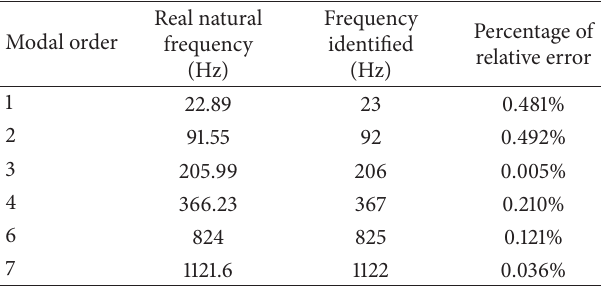
Table 9: Error of natural frequencies identified by maximum likelihood estimation with stochastic gradient descent method.